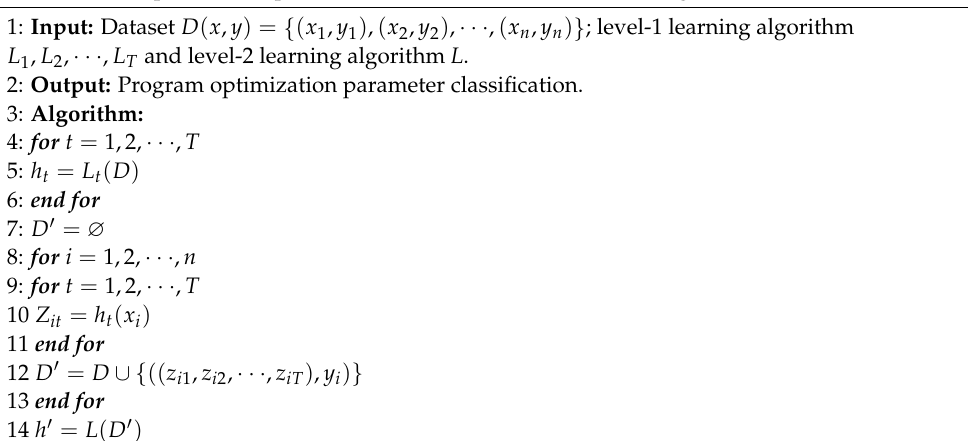
Algorithm 3 Optimization parameter selection based on the Stacking ensemble